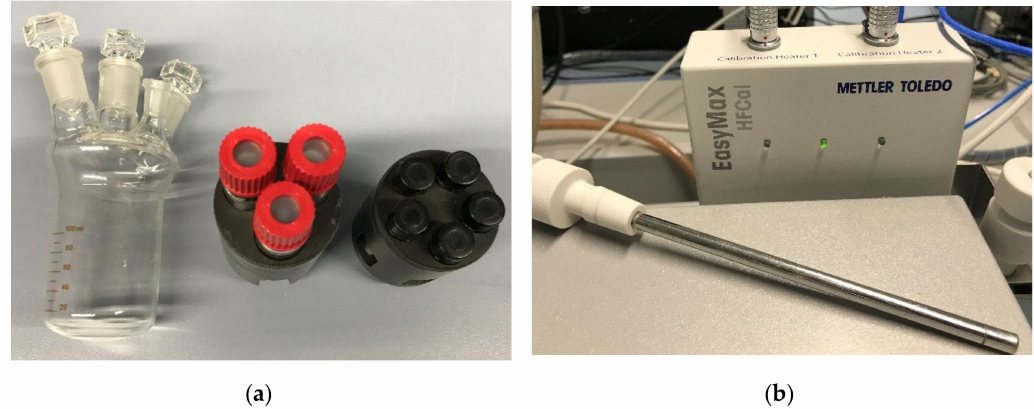
Figure 7. Sample containers of the stability testing device “HSLU” ( a ), reaction calorimetry unit ( b ).